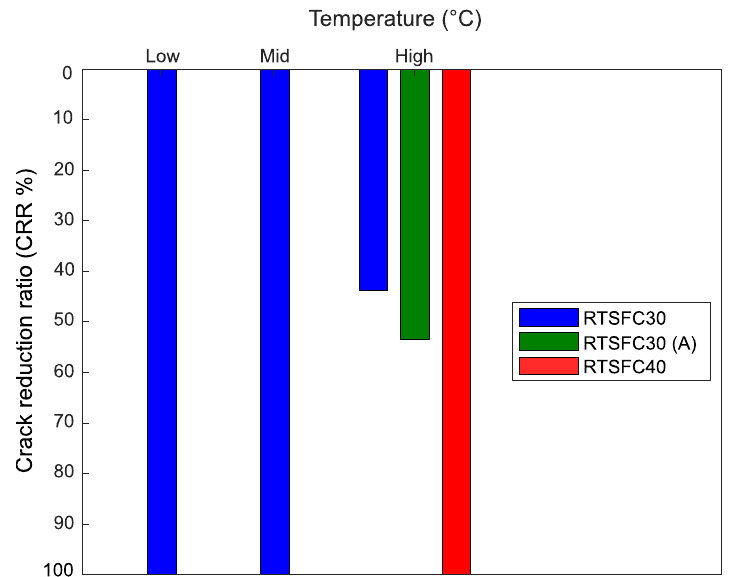
Figure 16. Crack reduction ratio for all temperatures.